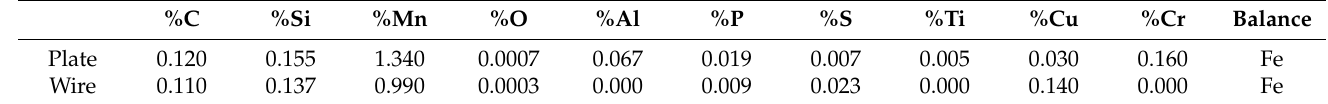
Table 1. Carbon steel base plate and weld wire compositions (mass%) [27].